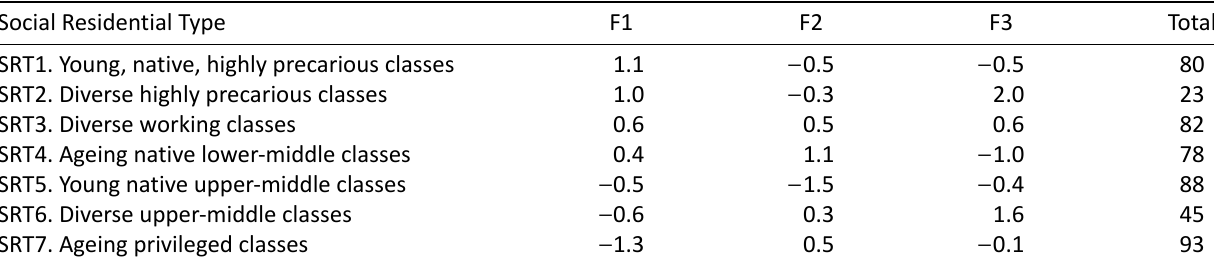
Table 3. Centre of each SRT for each social residential inequality factor (2011). Social Residential Type